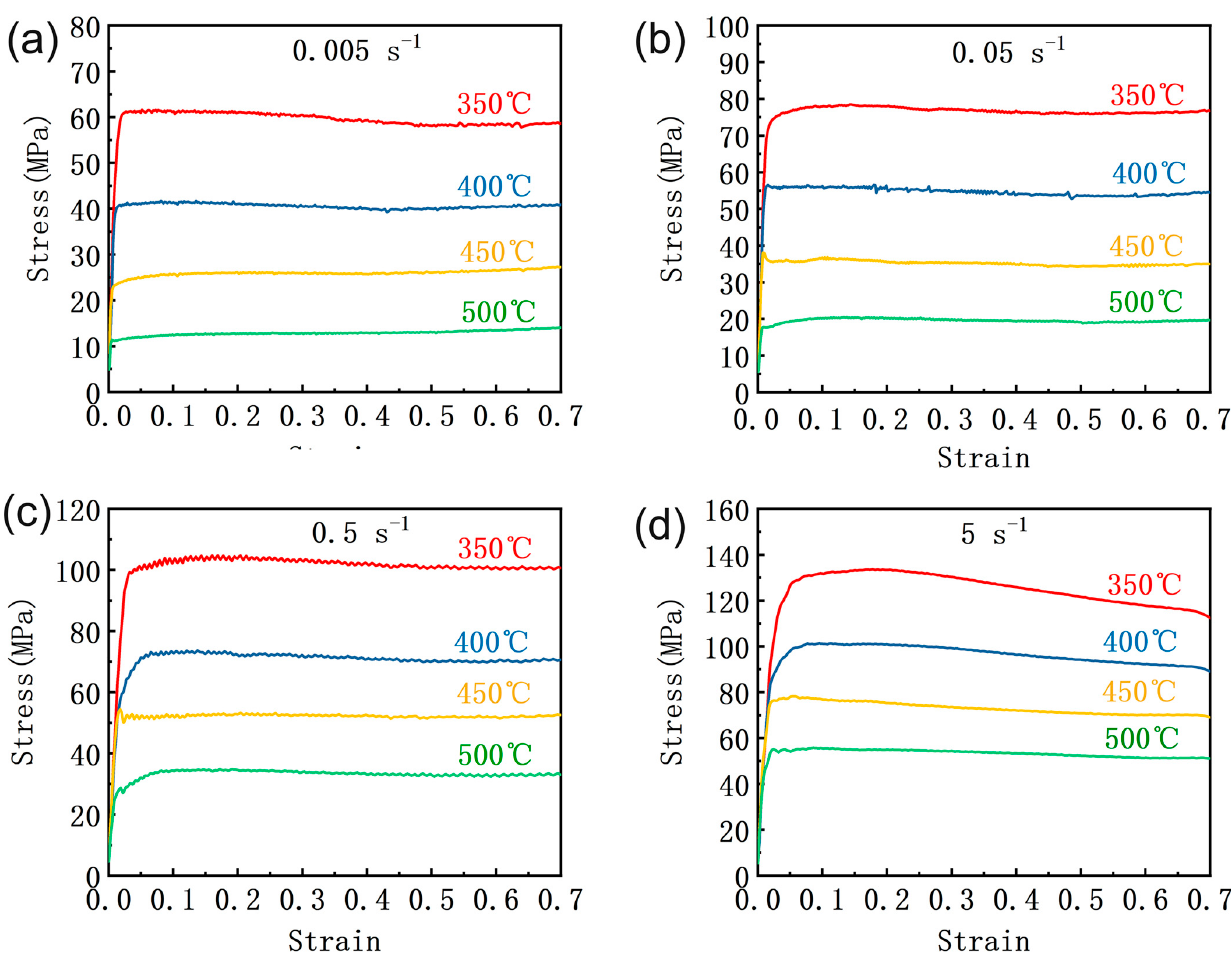
Figure 3. True stress–strain curves of the SiCp/6013 composites under different compression condi- tions: ( a ) 0.005 s − 1 ; ( b ) 0.05 s − 1 ; ( c ) 0.5 s − 1 ; ( d ) 5 s − 1 .